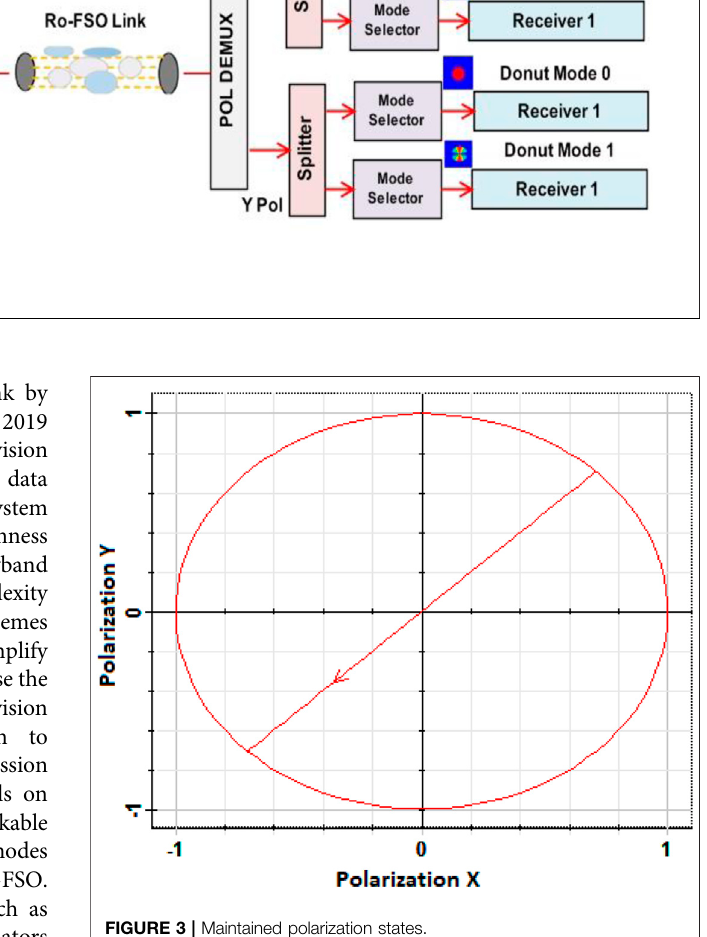
FIGURE 3 | Maintained polarization